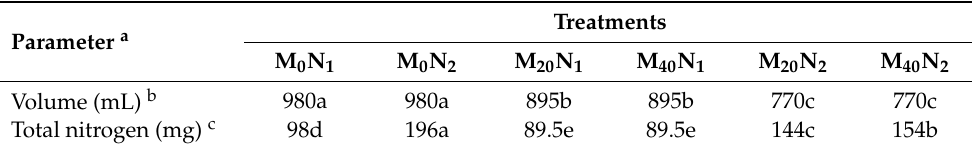
Table 1. Consumption of wastewater parameters in the improved vermicomposting system until 60th